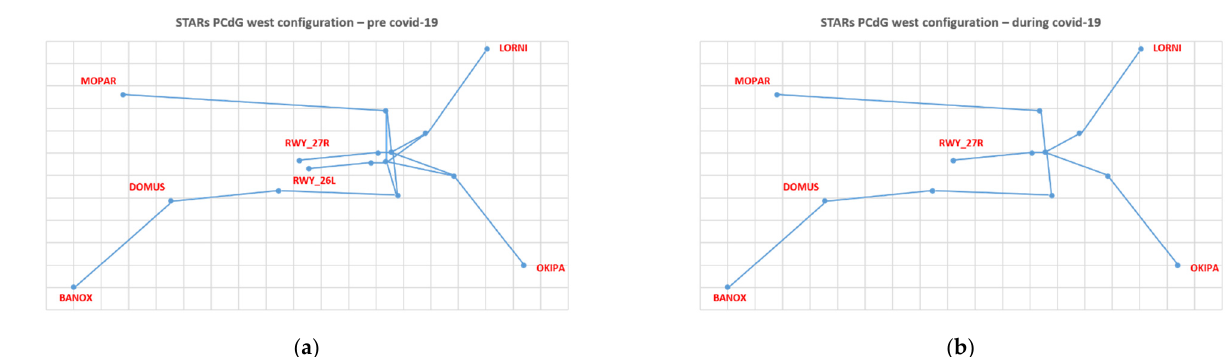
Figure 3. Pre COVID-19 ( a ) and during COVID-19 ( b ) CDG airport airspace structure.